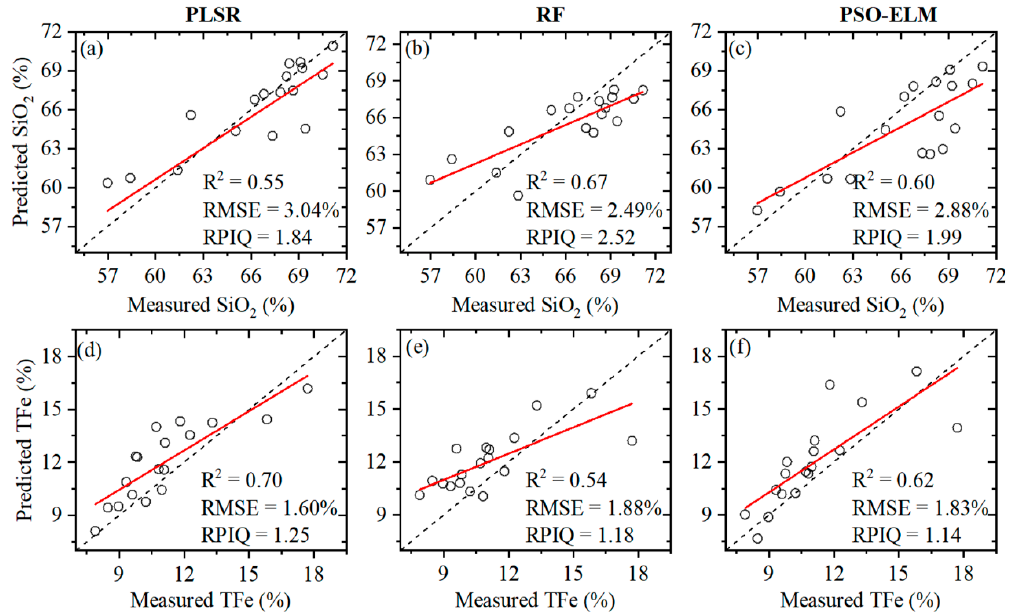
Figure 10. Validation between the measured and predicted value of SiO 2 ( a – c ) and TFe ( d – f ) in the 8–9.4 μ m and 10.7–12 μ m range from TIR using the PLSR, RF, and PSO–ELM models. The dashed line shows the 1:1 relationship and the red line shows the model trend.In the data augmentation domain, the input spectra with ranges of 1163–2499 nm, 8–9.4 μ m, and 10.7–12 μ m for TFe content and 1365–1391 nm, 1410–1623 nm, 8–9.4 µ m, and 10.7–12 µ m for SiO 2 content were selected to develop multivariate regression models. As shown in Figure 11, the RF model produced the best prediction for TFe and SiO 2 with R 2 = 0.87 and 0.90, RMSE = 1.10% and 1.28%, and RPIQ = 2.02 and 4.90,